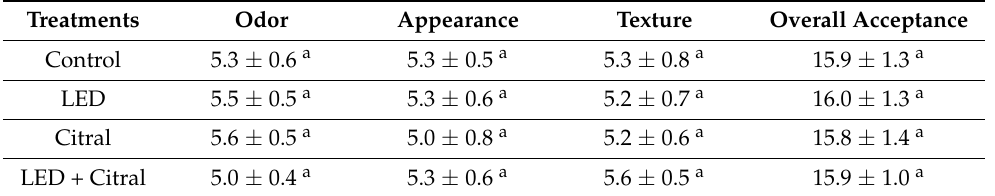
Figure 1. Effect of combination of 405 nm LED and 0.1 mg/mL of citral on sensory evaluation of shrimp. ( A ) Untreated, ( B ) treated with 405 nm LED irradiation for 120 min, ( C ) treated with 0.1 mg/mL of citral for 120 min, and ( D ) LED treatment combined with 0.1 mg/mL of citral for 120 min. Table 3. Sensory evaluation of fresh shrimp with LED illumination, 0.1 mg/mL of citral, and LED plus 0.1 mg/mL of citral treatment for 120 min.